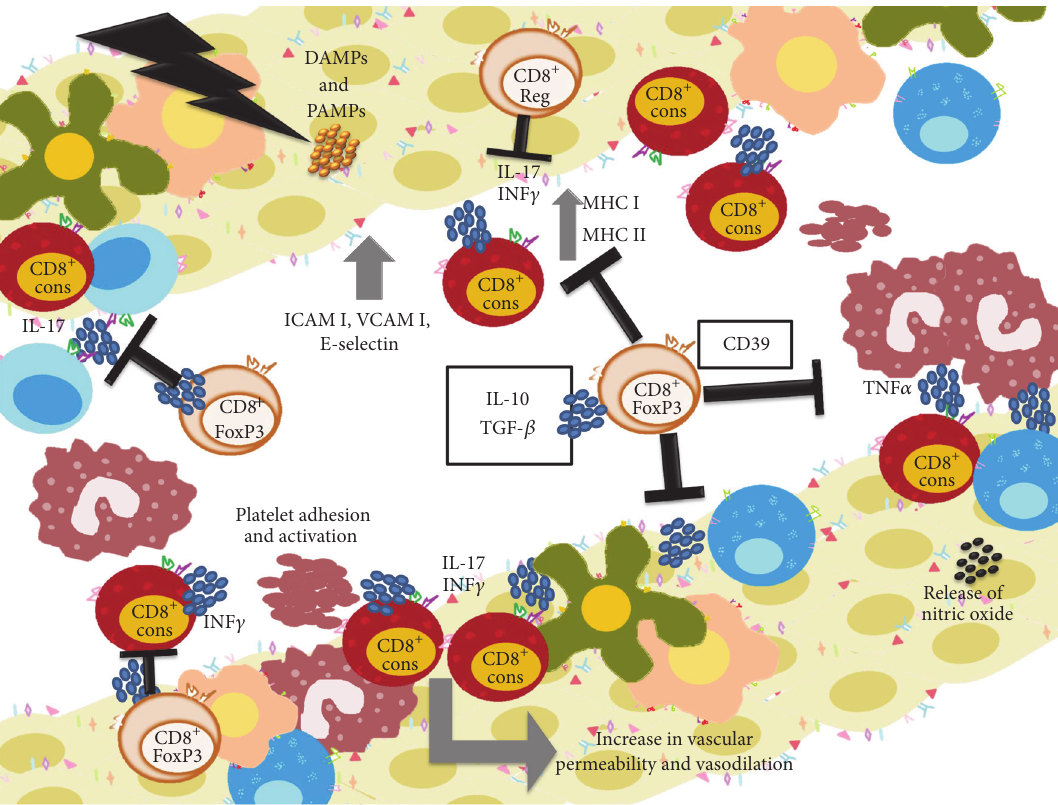
Figure 6: Peripheral regulatory mechanism that controls the development of GVHD. The development of GVHD is characterized by activation of T donor cells. Donor T cell activation results mainly in IFN 𝛾 and IL-17 production; the IFN 𝛾 promotes the increase of MHC, adhesion molecules, nitric oxide release, and vasodilation and increased permeability. This results in further increases in antigen presentation and activation and expansion of cytotoxic CD8 + and CD4 + T cells; these cells migrate to the target organs, where they mediate tissue injury that leads to multiorgan failure. Nevertheless, there are subpopulations that can intervene at different stages of GVHD and control it; the subpopulation named CD8 + Treg can intervene and block activation and expansion of effector cells, through IL-10 and TGF 𝛽 production and expression of CD39; these cells reduce the inflammatory